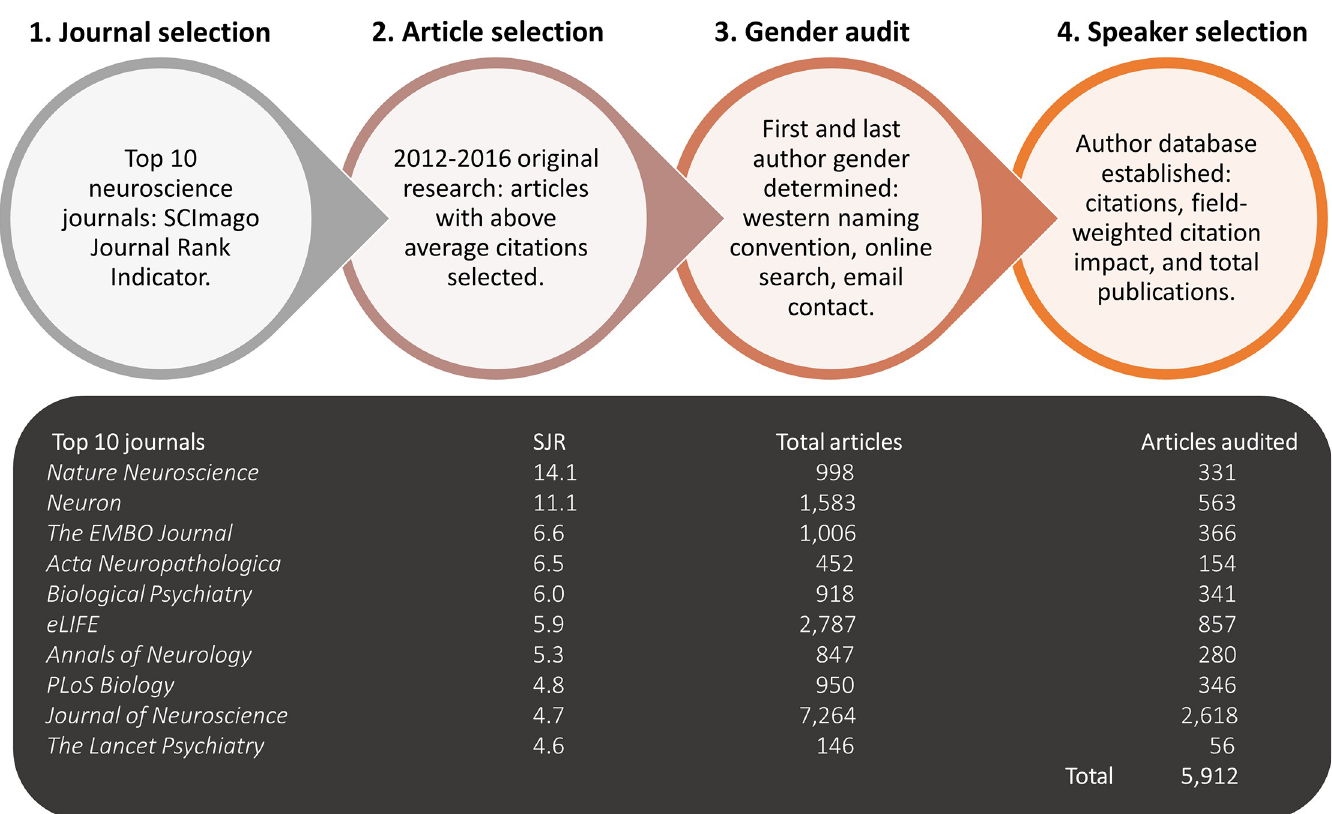
Fig 1. Selection procedure for creating a database for speaker